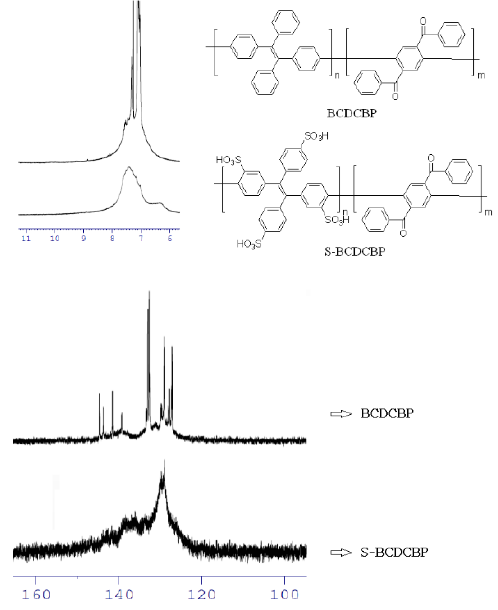
Figure 1. 1 H ‐ NMR and 13 C ‐ NMR spectra of SBCDCBP polymers. Figure 1. 1 H-NMR and 13 C-NMR spectra of SBCDCBP